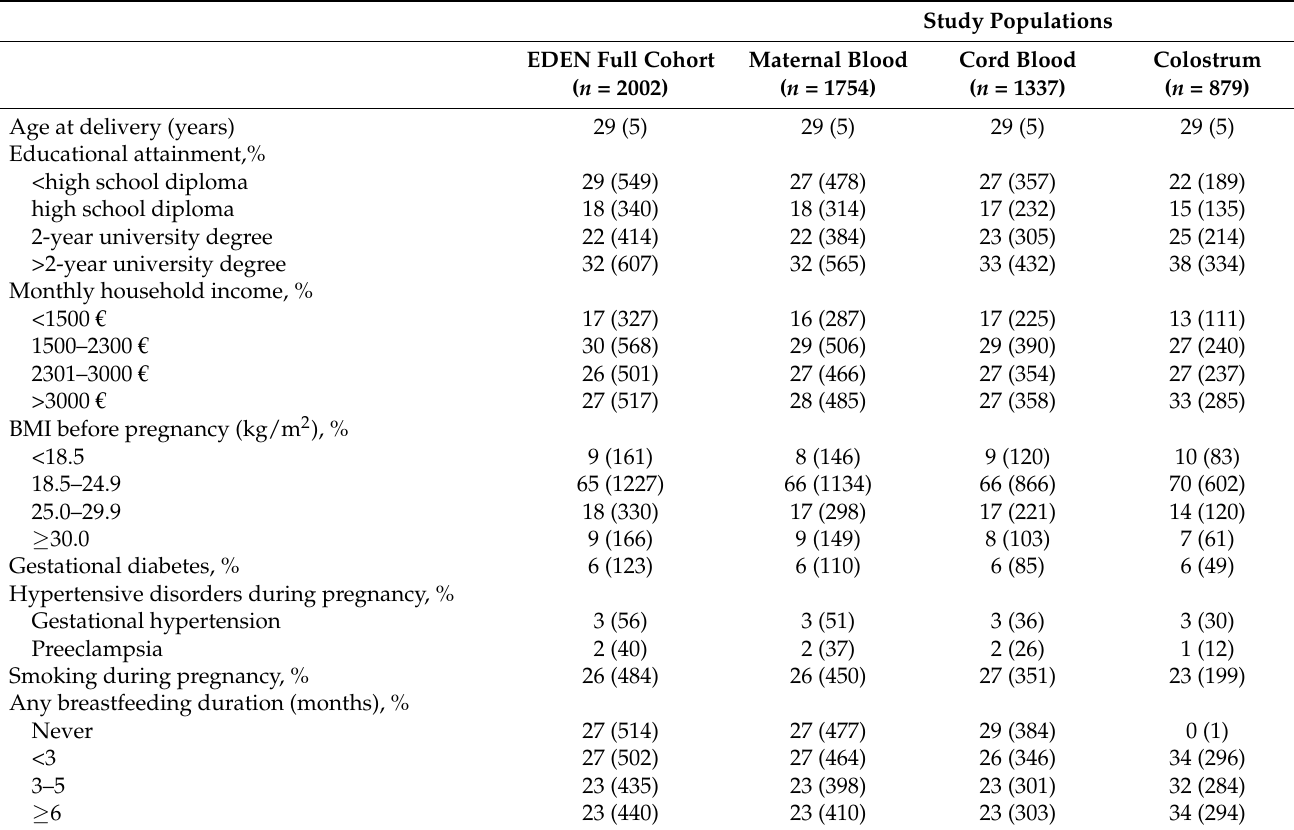
Table 2. Description of maternal characteristics in the study populations 1